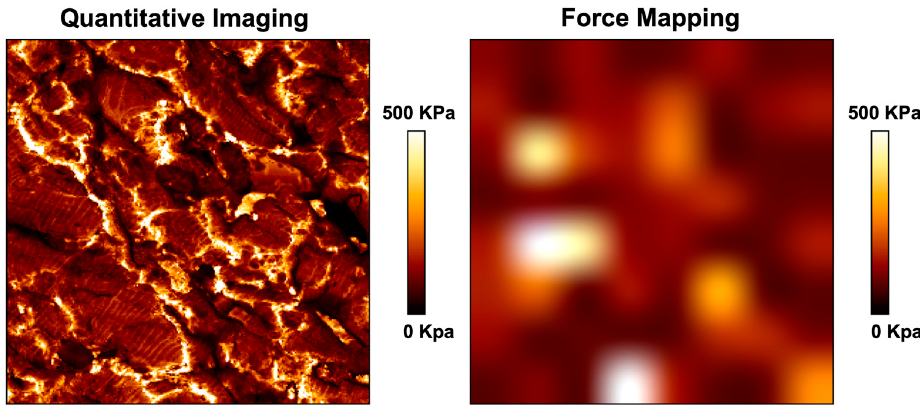
Figure 7. Stiffness mapping obtained by QI ( left ) and force mapping ( right ). Area analyzed 10,000 μ m 2 .